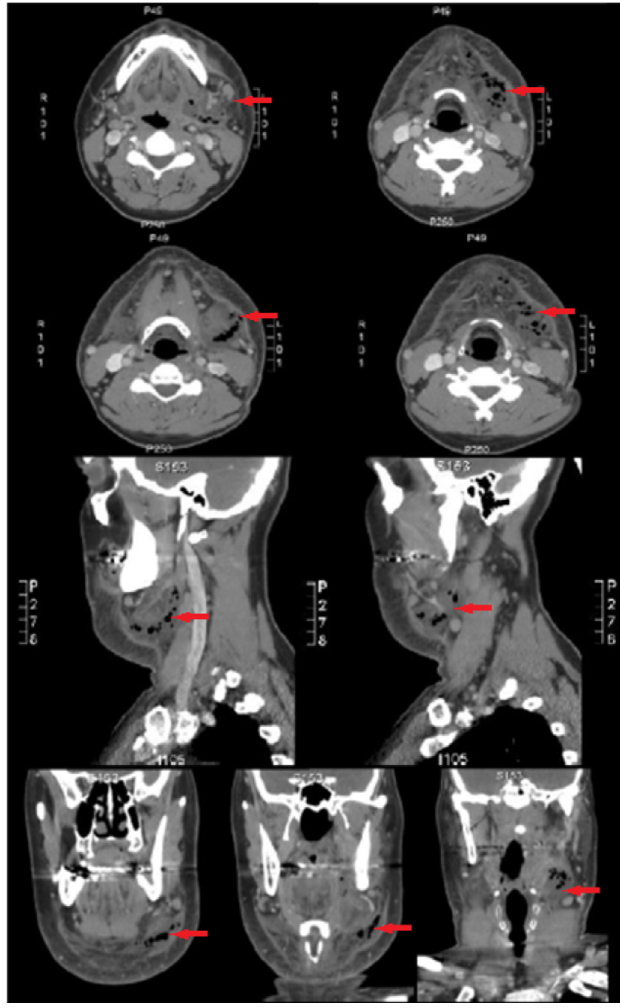
Fig. 3. Cervical CT scan with radiocontrast